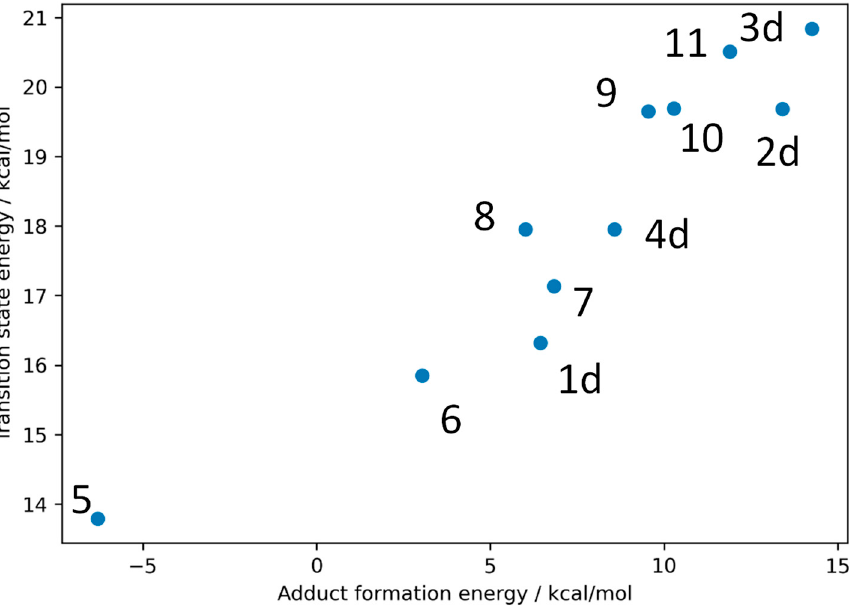
Figure 7. Calculated transition states and adduct formation energies for the seven new warhead substituted molecules with the molecules from the benchmark set 1d–4d.